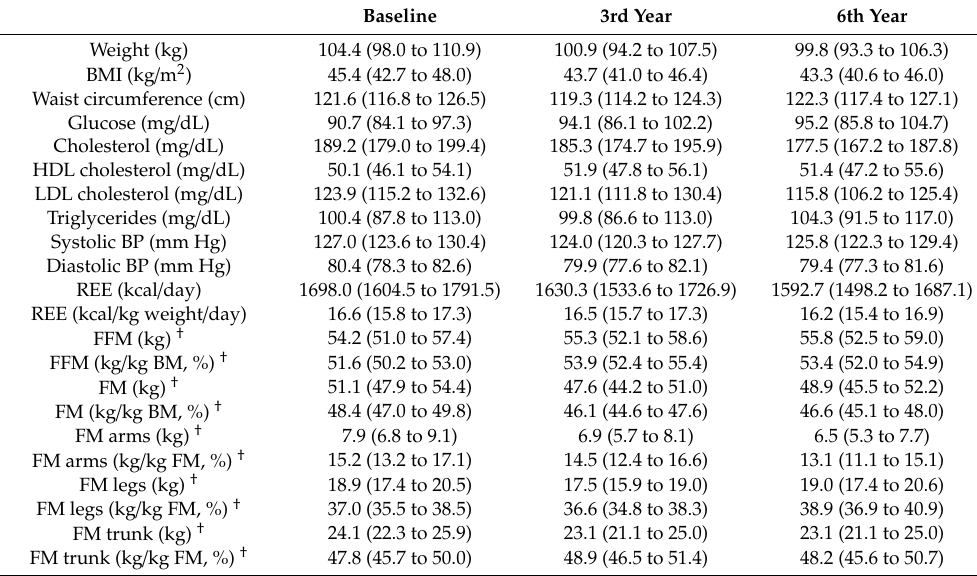
Available for 36 (80%) of 45 patients (see Table 1). Values are means and 95% confidence intervals estimated by random-e ff ects linear regression. Abbreviations: BMI = body mass index; BP = blood pressure; BM = body mass; REE = resting energy expenditure; FFM = fat-free mass; FM = fat mass. Table 3 reports the absolute values of anthropometry, laboratory measurements, blood pressure, and REE for all patients ( n = 45) and the absolute values of total and segmental body composition for patients with availability of DXA ( n = 36, 80%). To understand the connection of Table 3 with Table 2, note that the intercept given in Table 2 corresponds to the mean baseline value given in Table 3